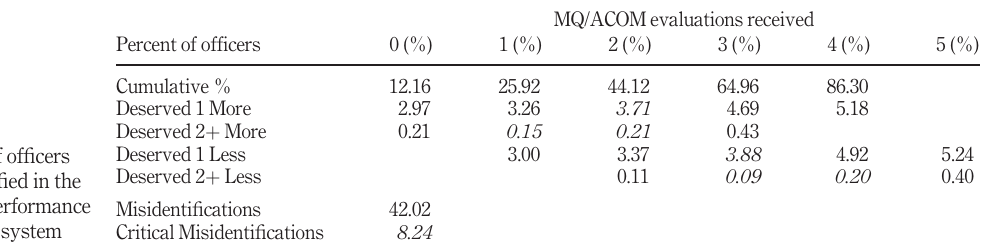
misidenti fi ed in